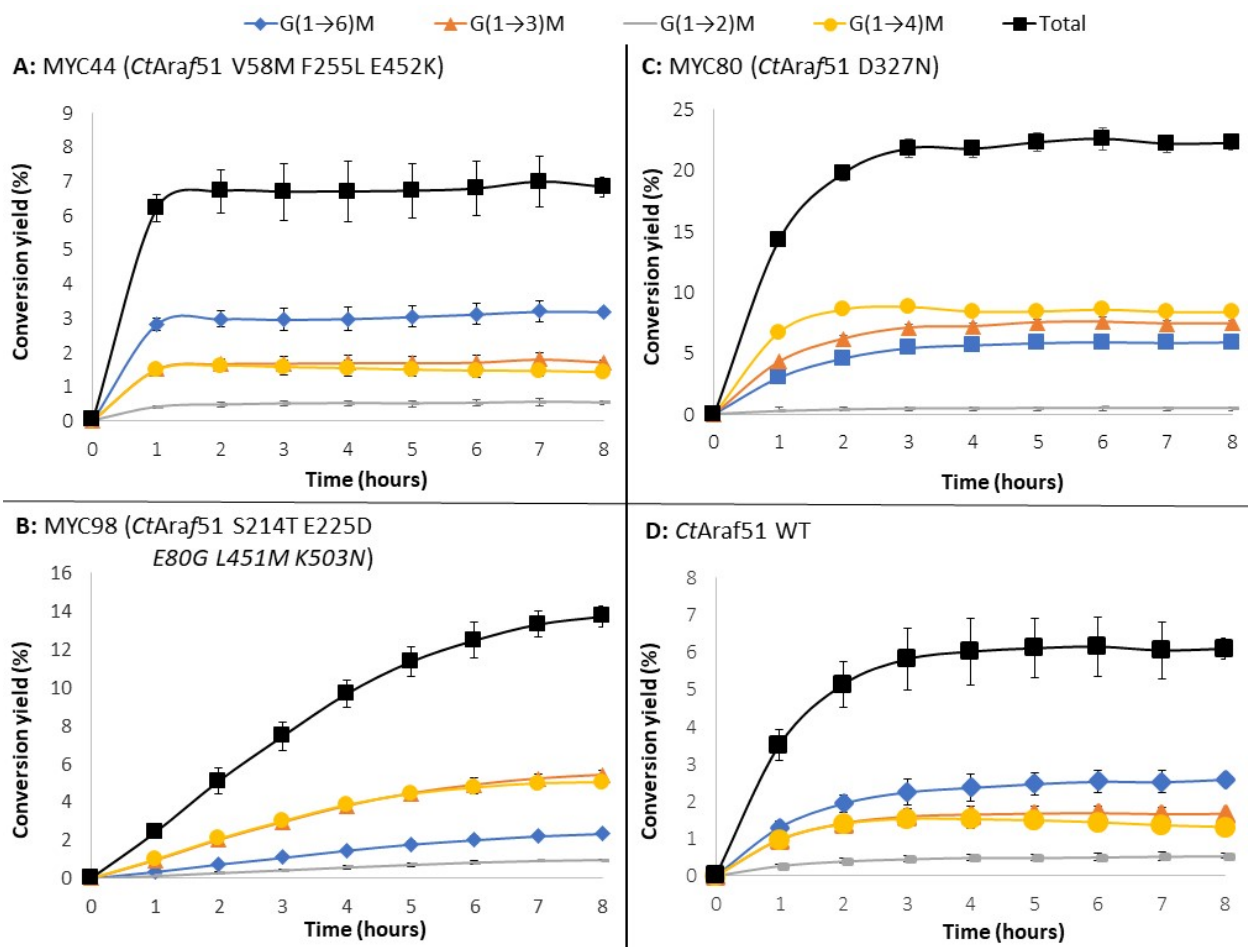
Figure 4. Transglycosylation kinetics with the Ct Ara f 51 WT enzyme and mutants directly selected during the screening (( A ): MYC44, ( B ): MYC98, ( C ): MYC80, ( D ): WT). Mutations labelled in italic have no influence either on the transglycosylation yield nor on the regioselectivity. A total of 10 mM of Gal f ‐ octyl and 60 mM of Man p ‐ p NP were used at 60 °C. The error bars represent the standard deviation of three independent experiments.